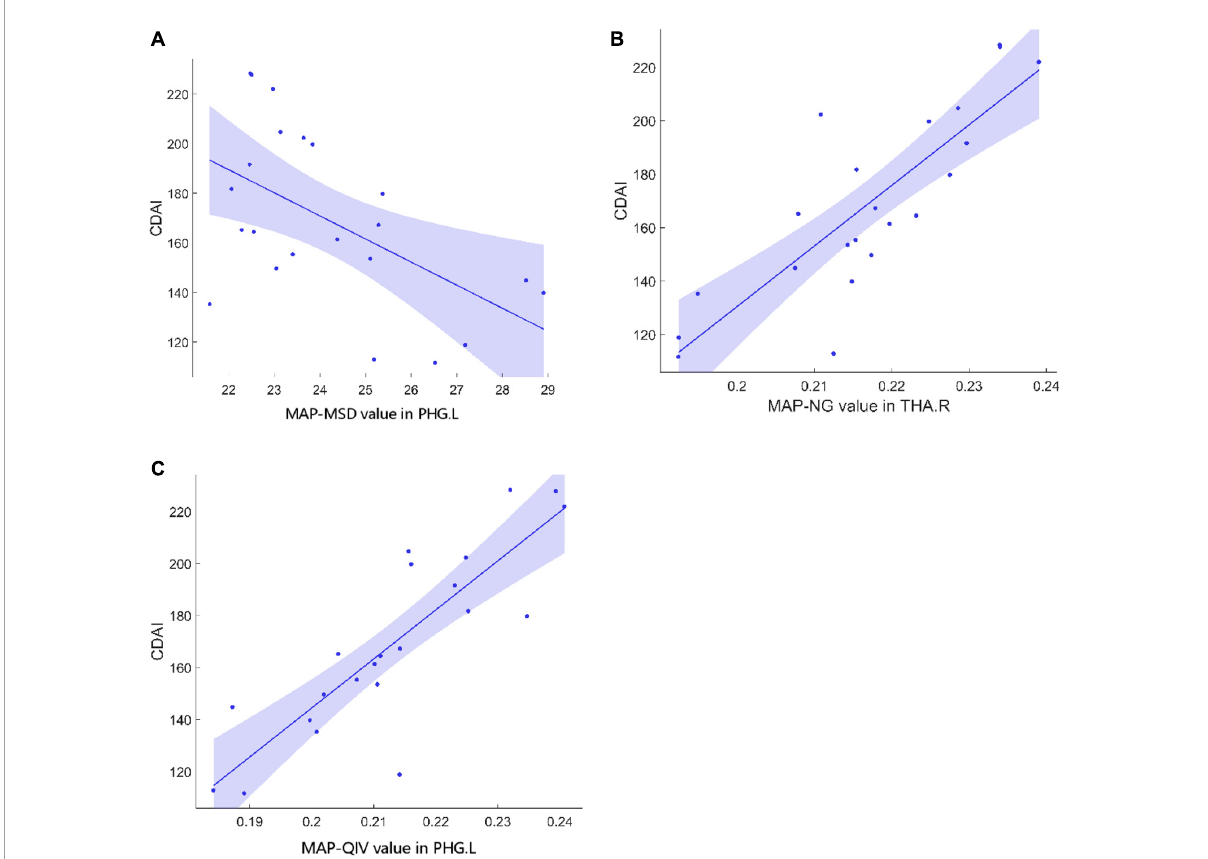
FIGURE1 Correlations between MAP parameters and CDAI in CD patients. (A) The MSD value in PHG.L ( r = –0.61, p = 0.02) was negatively correlated with CDAI. (B) The NG value in THA.R ( r = 0.53, p = 0.019) was positively correlated with CDAI. (C) The QIV value in PHG.L ( r = 0.70, p = 0.005) was positively correlated with CDAI. MAP, mean apparent propagator; CDAI, Crohn’s Disease Activity Index; CD, Crohn’s Disease; MSD, mean square displacement; PHG.L, left parahippocampal gyrus; NG, non-Gaussianity; THA.R, right hippocampus; QIV, Q-space inverse variance.